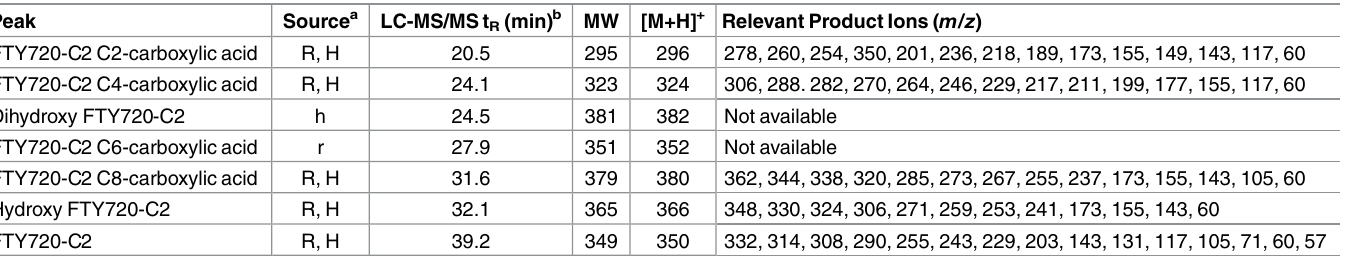
Table 4. Summaryof the structural characterizationby LC-MS/MSof FTY720-C2 Metabolites Identified in Rat and HumanHepatocytes. Peak